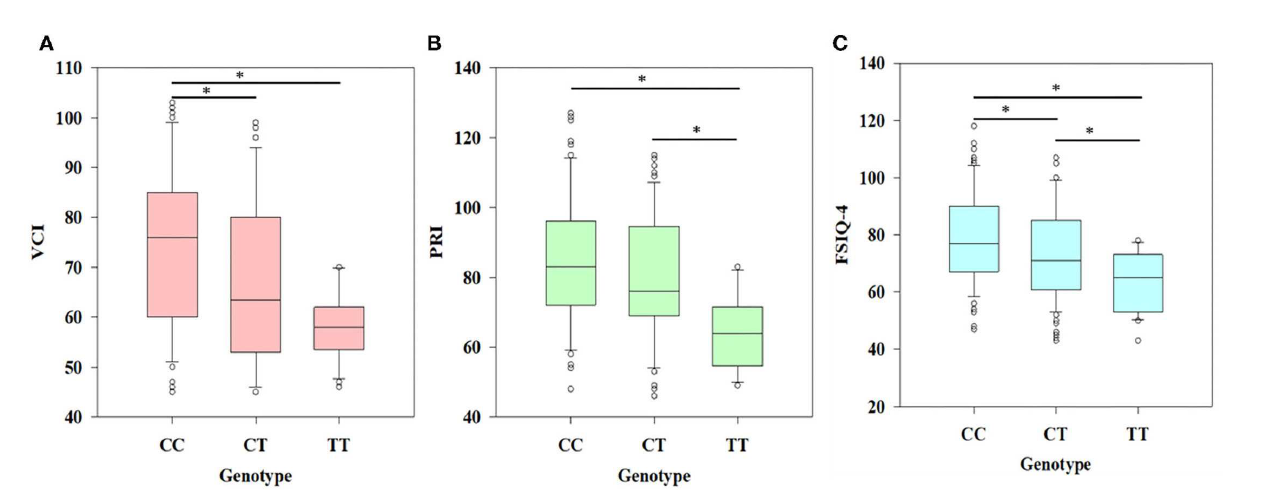
FIGURE1 Association of different genotypes (CC, CT, and TT) and psychometric traits shown by the results of ANOVA. (A) Significant difference ( p < 0.001) was observed in the case of VCI (verbal comprehensive index) between CC and TT genotype and CC and CT genotype, (B) significant difference ( p < 0.001) was observed in the case of PRI (perceptual reasoning index) between CC and TT genotype and CT and TT genotype, and (C) FSIQ-4 (full scale intelligence quotient-4) showing significant differences ( p < 0.001) among all three genotypes ( * p <